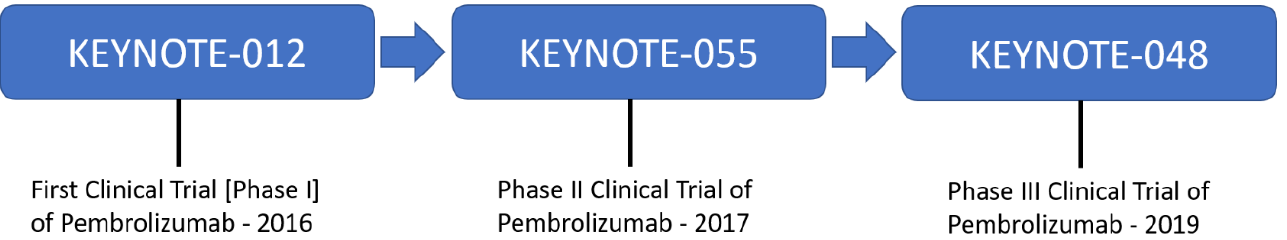
Figure 2. Schematic representation of the pembrolizumab clinical trials, which started in 2013 and ended in 2019, with phase I ending in 2016, phase II ending in 2017, and phase III ending in 2019. The successful outcome of these clinical trials resulted in FDA approval of pembrolizumab for the treatment of HNSCC.